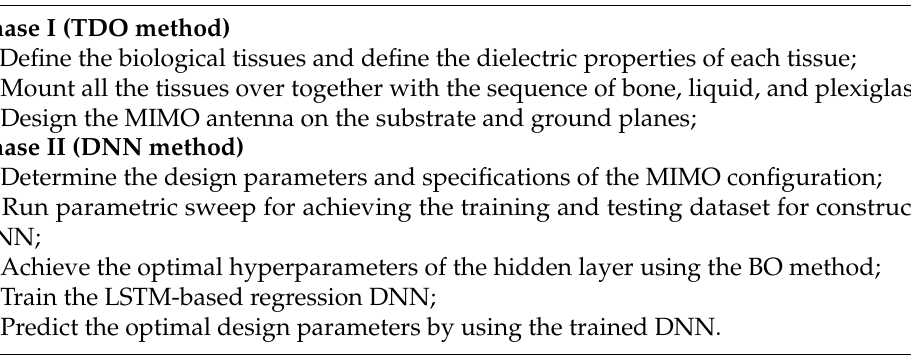
Algorithm 1 Automatic methodology for optimizing implanted MIMO antennas using sequential TDO and DNN methods Phase I (TDO